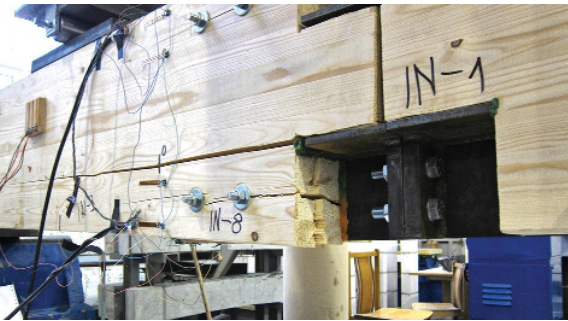
Fig. 7. Load – displacement curve of J-1-PUR and J-2-CEM beam‘s (joint) middle point